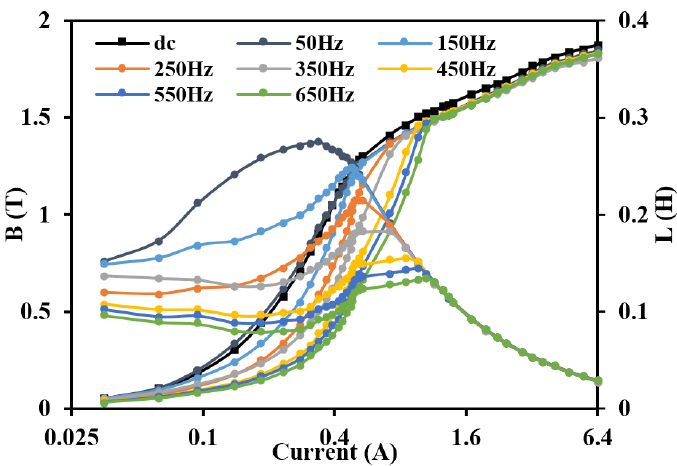
Figure 6. B - H curves and inductances with various frequencies.